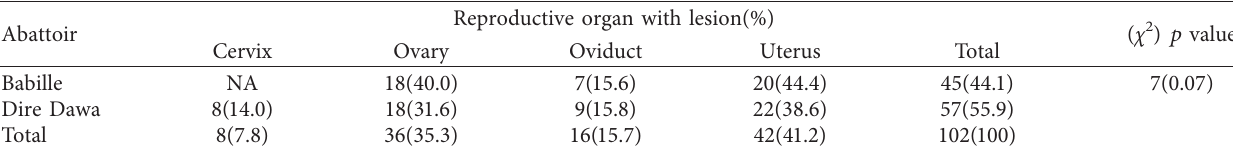
Table 3: Prevalence of pathological lesions in reproductive organs of female camels at Dire Dawa and Babille municipal abattoirs. Reproductive organ with lesion(%) Abattoir